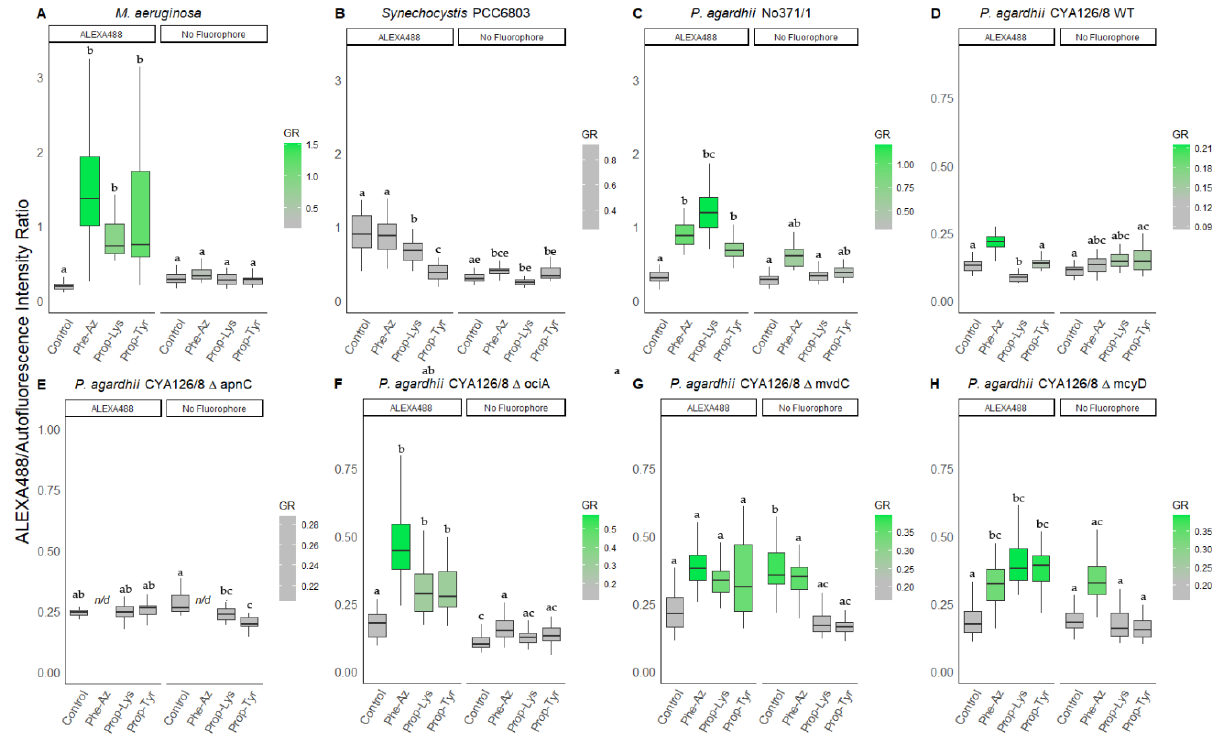
Figure 3. The ratio of green fluorescence intensity (ALEXA488) to red intensity (AF) for individual cells or filaments from ( A ) M. aeruginosa , ( B ) Synechocystis PCC6803, and ( C ) P. agardhii strain No371/1, ( D ) CYA126/8 WT, and ( E – H ) CYA126/8 gene knock out mutants: ( E ) Δ apnC (inactivated AP synthesis), ( F ) Δ ociA (inactivated cyanopeptolin synthesis), ( G ) Δ mvdC (inactivated microviridin synthesis), and ( H ) Δ mcyD (inactivated MC synthesis) using non-natural amino acids (Phe-Az, Prop-Lys, and Prop-Tyr). Controls were grown without amino acid addition but used for the chemical reaction under identical conditions. No Fluorophore indicates filaments or cells grown with amino acid addition but no subsequent labeling by click-chemical reaction. The gradient in coloring was defined for each strain separately using the average intensity from the control cultures. Superscripts indicate statistically significant different subgroups after overall difference was found ( p < 0.05).